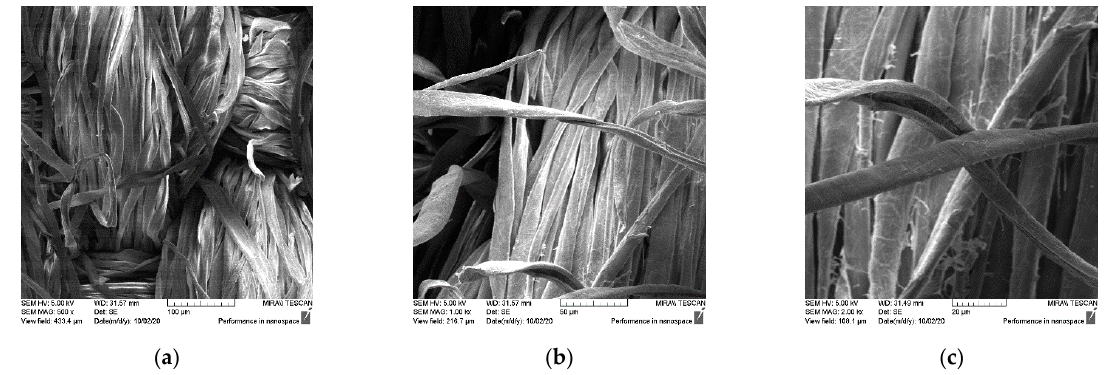
Figure 1. SEM micrographs of untreated plain weave cotton fabric at the magnifications of: ( a ) 500x, ( b ) 1000x, and ( c ) 2000x.